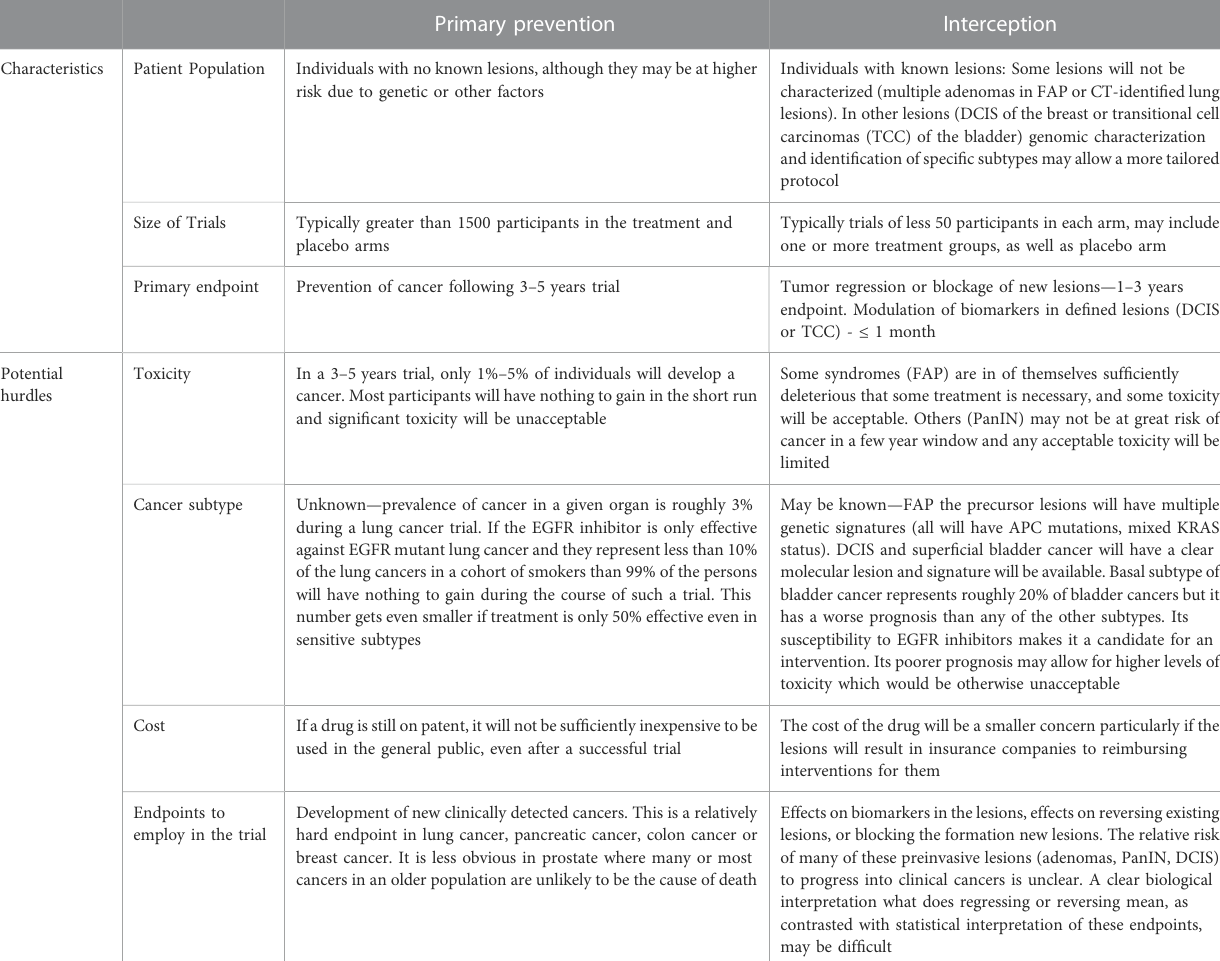
TABLE 1 Trial characteristics and potential hurdles in primary prevention and interception studies using EGFR